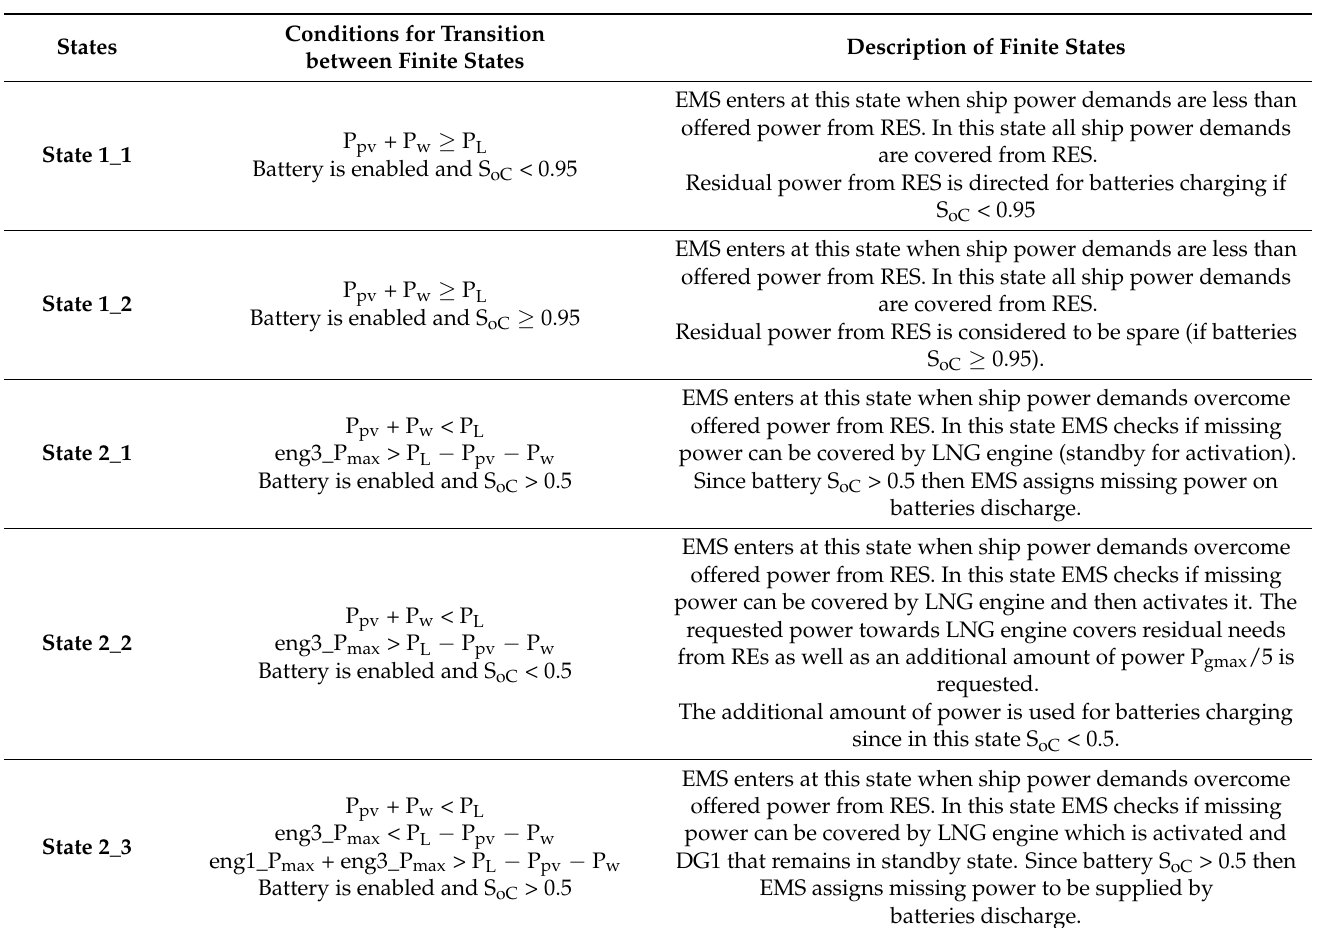
Table 3. EMS States and